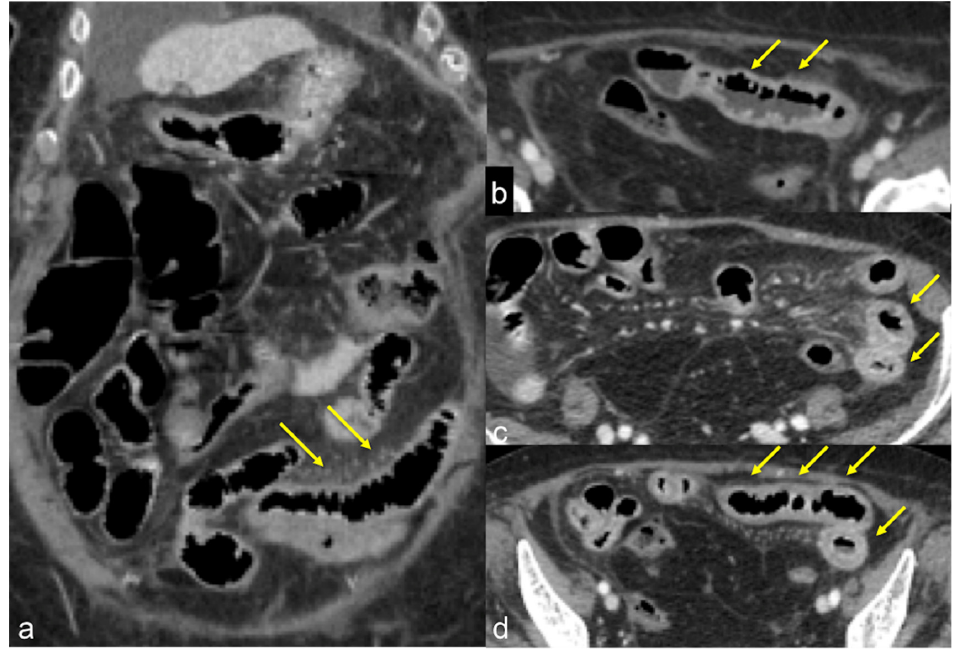
Figure 40. Reactivation of Crohn’s ileitis. Enhanced CTA scan in portal venous phase in coronal ( a ) and axial ( b – d b;c;d;d;e;f;d;e;f;a;b;c;a;b;c;d ) views. Note the ileal wall thickening with segmental irregularity and hyperaemia of the mucosa.